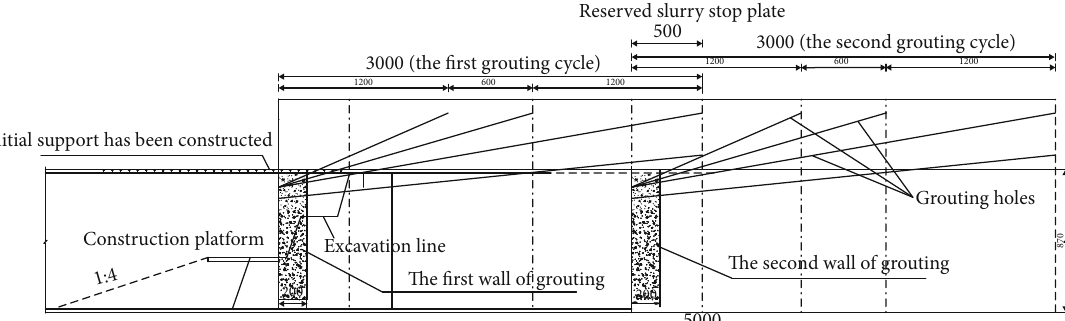
Figure 9: Vertical section of grouting (units: cm).